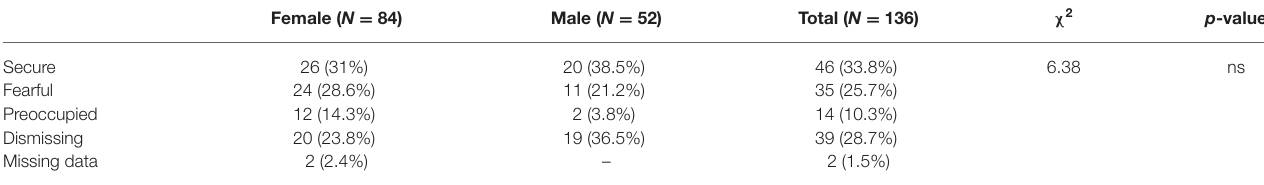
TABLE 2 | Cross-tabulation of gender and attachment style.